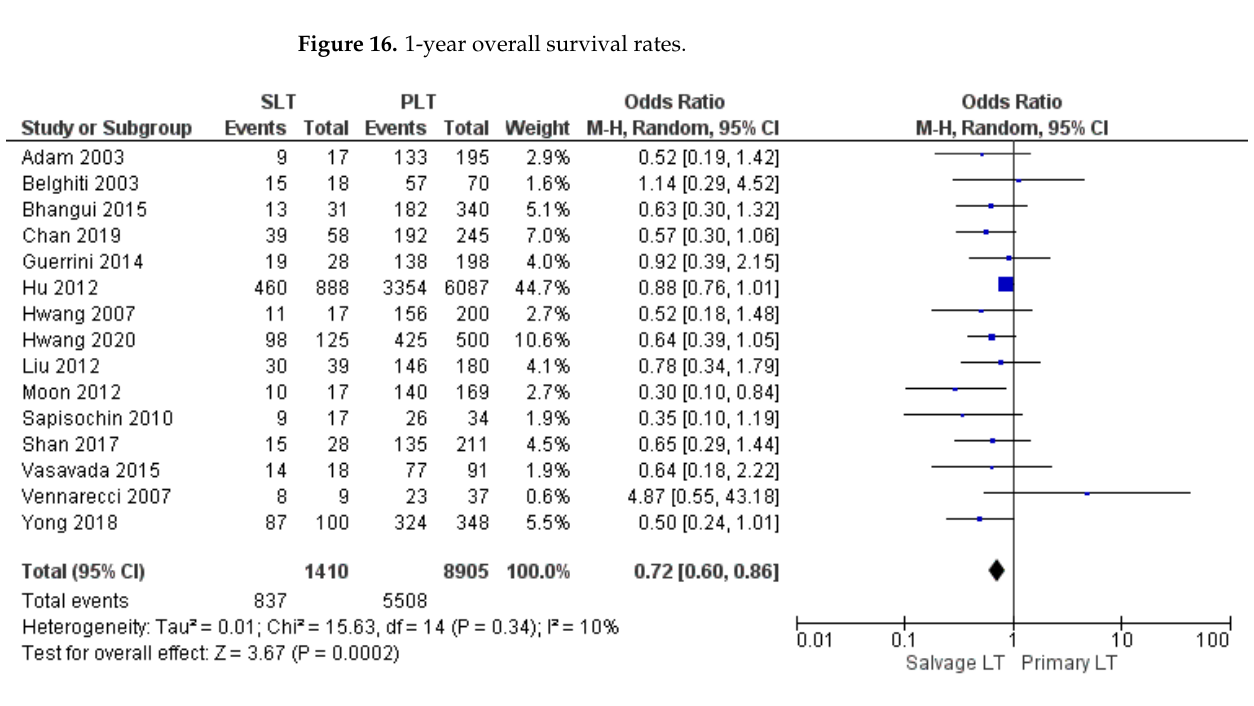
Figure 17. 3 - year overall survival rates.